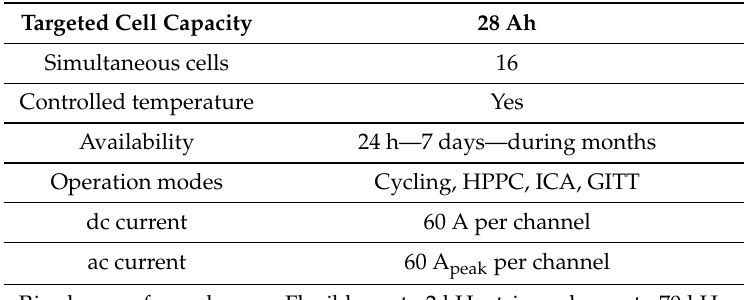
Table 1. Experimental setup specification